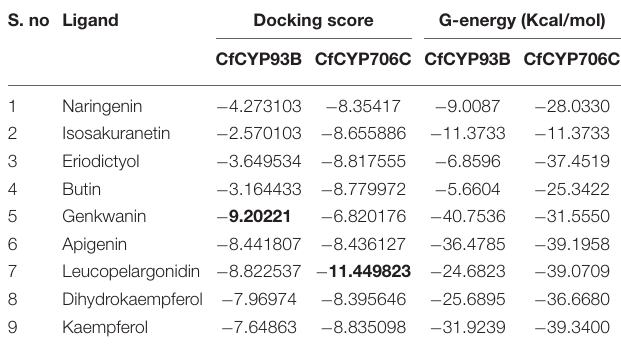
TABLE 1 | Docking scores of ligands with CfCYP93B and